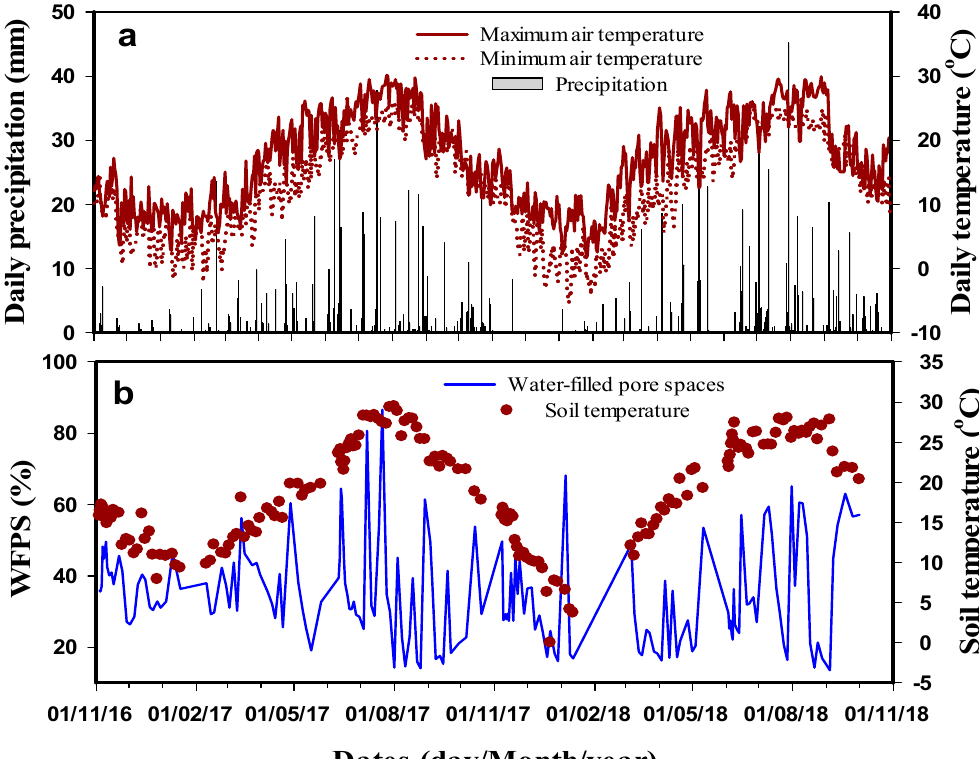
Figure 1. ( a ) Daily precipitation (mm), daily maximum and minimum air temperature (°C) and ( b ) seasonal variations in mean soil water ‐ filled pore space (WFPS) and mean soil temperature (topsoil at 5 cm) in the wheat ‐ maize rotations for the four treatments over the two ‐ year period from 2016 – 2018. For the winter wheat season, the mean cumulative CH 4 fluxes among the four treatments were − 1.54 kg · C · ha − 1 for CK, − 1.77 kg · C · ha − 1 for NPK, − 1.75 kg · C · ha − 1 for OMNPK, and − 2.02 kg · C · ha − 1